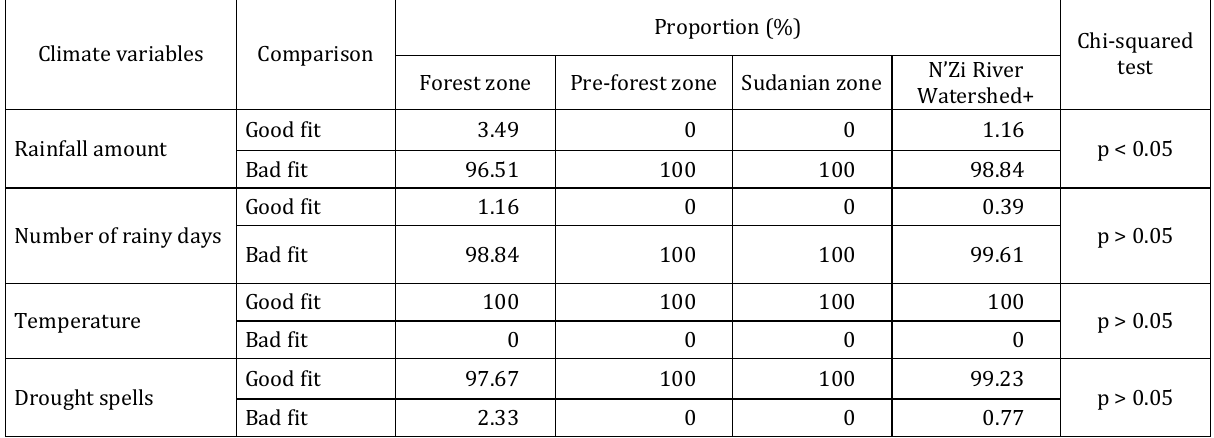
Proportion (%) Chi-squared